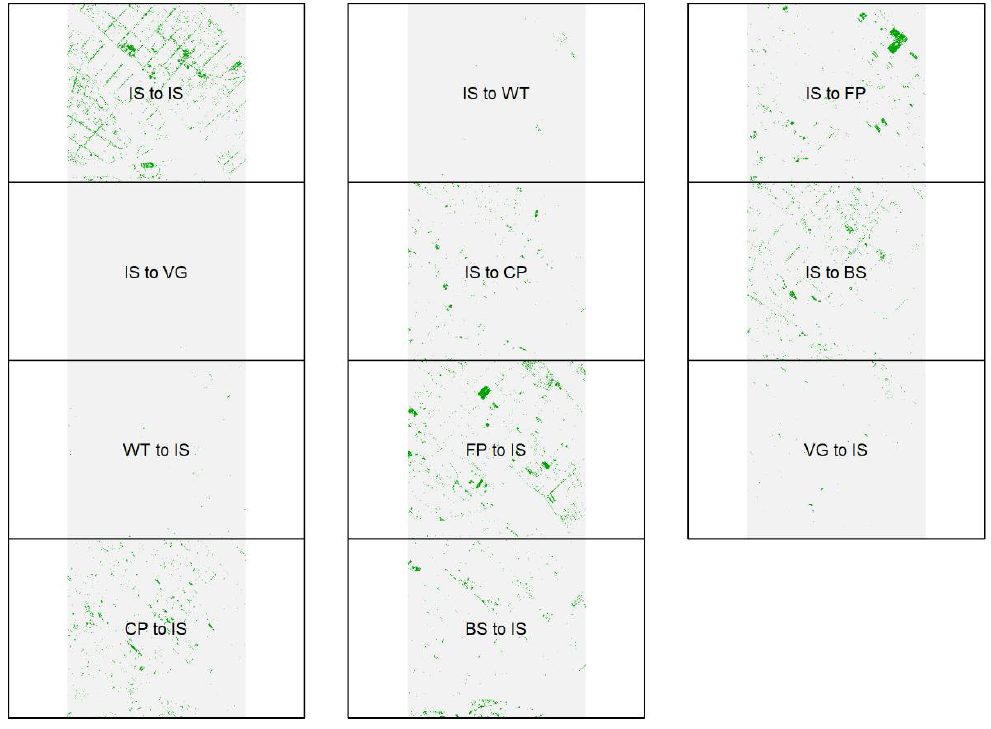
Figure 8. Change map of Region 2.